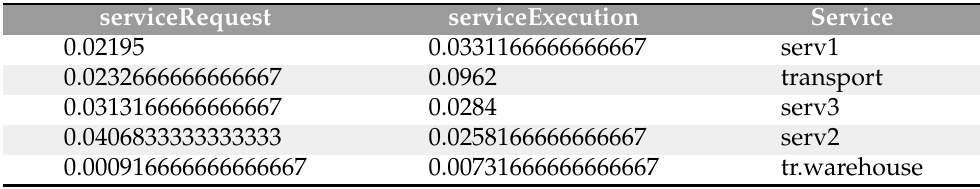
Table 4. Example of file content with run times per service.